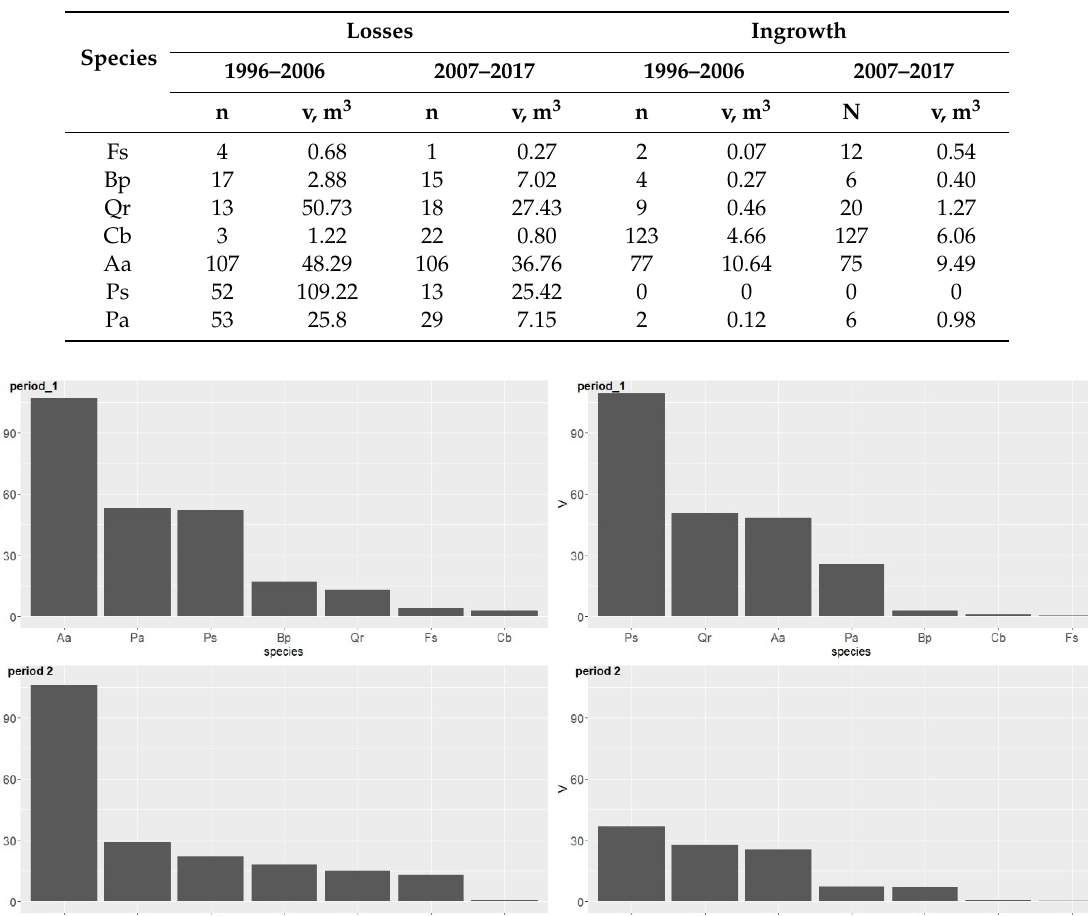
Table 4. Number (nha − 1 ) and volume (v, m 3 ha − 1 ) of species-specific losses and ingrowth over both periods (1996–2006 and 2007–2017) in the multispecies, uneven-aged forest. Losses Species